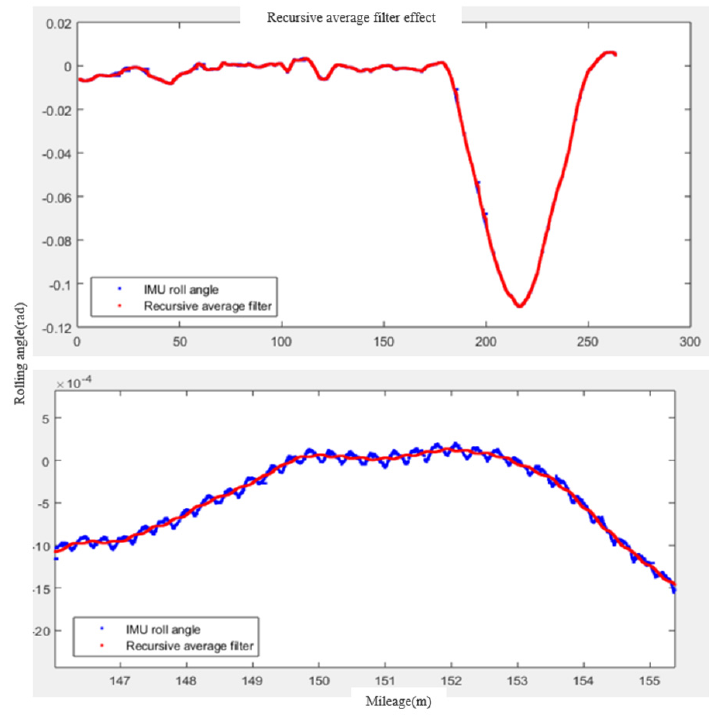
Figure 16. Recursive average filter effect.